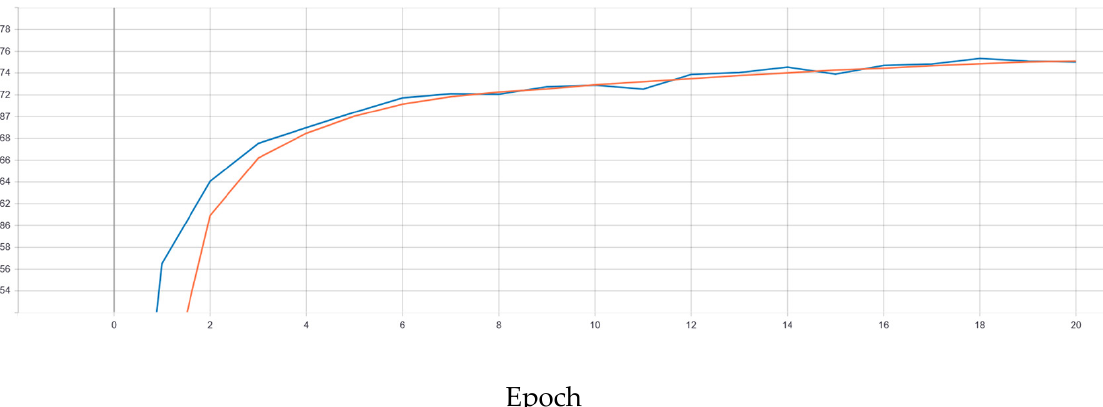
Figure 7. Loss vs. Epoch. After 21 epochs, the training loss (orange) has a value of 0.3040 and the validation loss (blue) has a value of 0.3041.